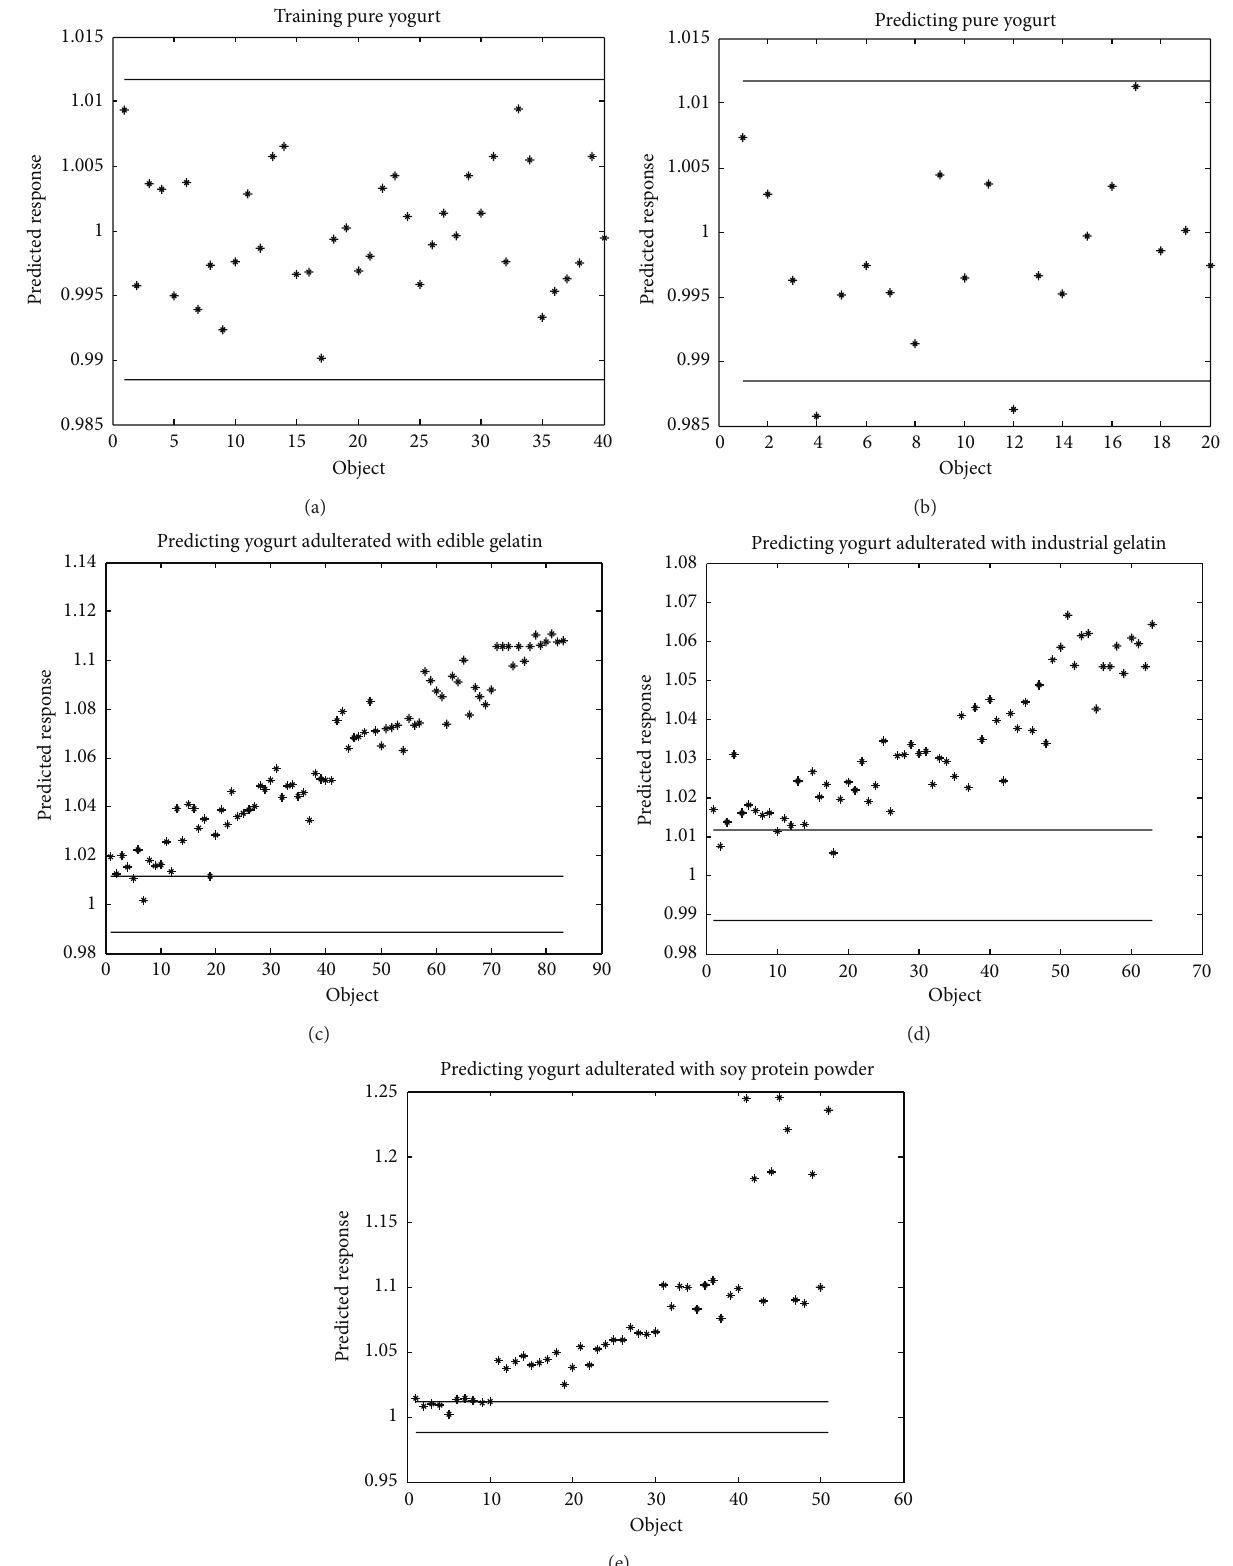
Figure 5: Training and predicting results obtained by orthogonally projected (OP) spectra and 5-component OCPLS model. For adulterated objects, the levels of adulterants, edible gelatin (1%, 2%, 3%, 4%, 6%, and 8%), industrial gelatin (0.5%, 1%, 2%, 3%, and 5%), and soy protein powder (0.5%, 1%, 2%, 3%, and 5%) are arranged in an ascending order along the 𝑥 -axis